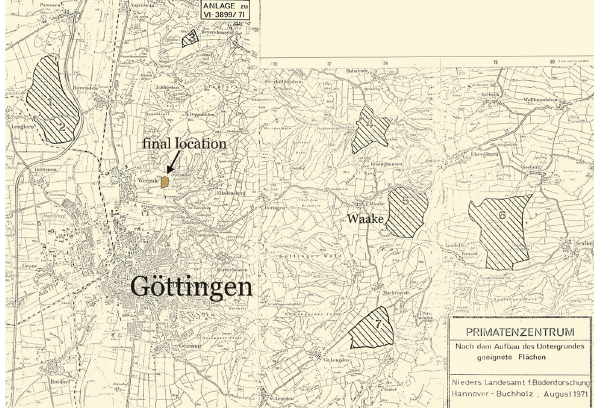
Figure 7. Map of area surrounding Göttingen from the Lower Sax- ony State Office for Soil Research, 1971 (modified with the fi- nal German Primate Center building site). A total of seven areas (hatched) around Göttingen were initially considered (picture from DPZ